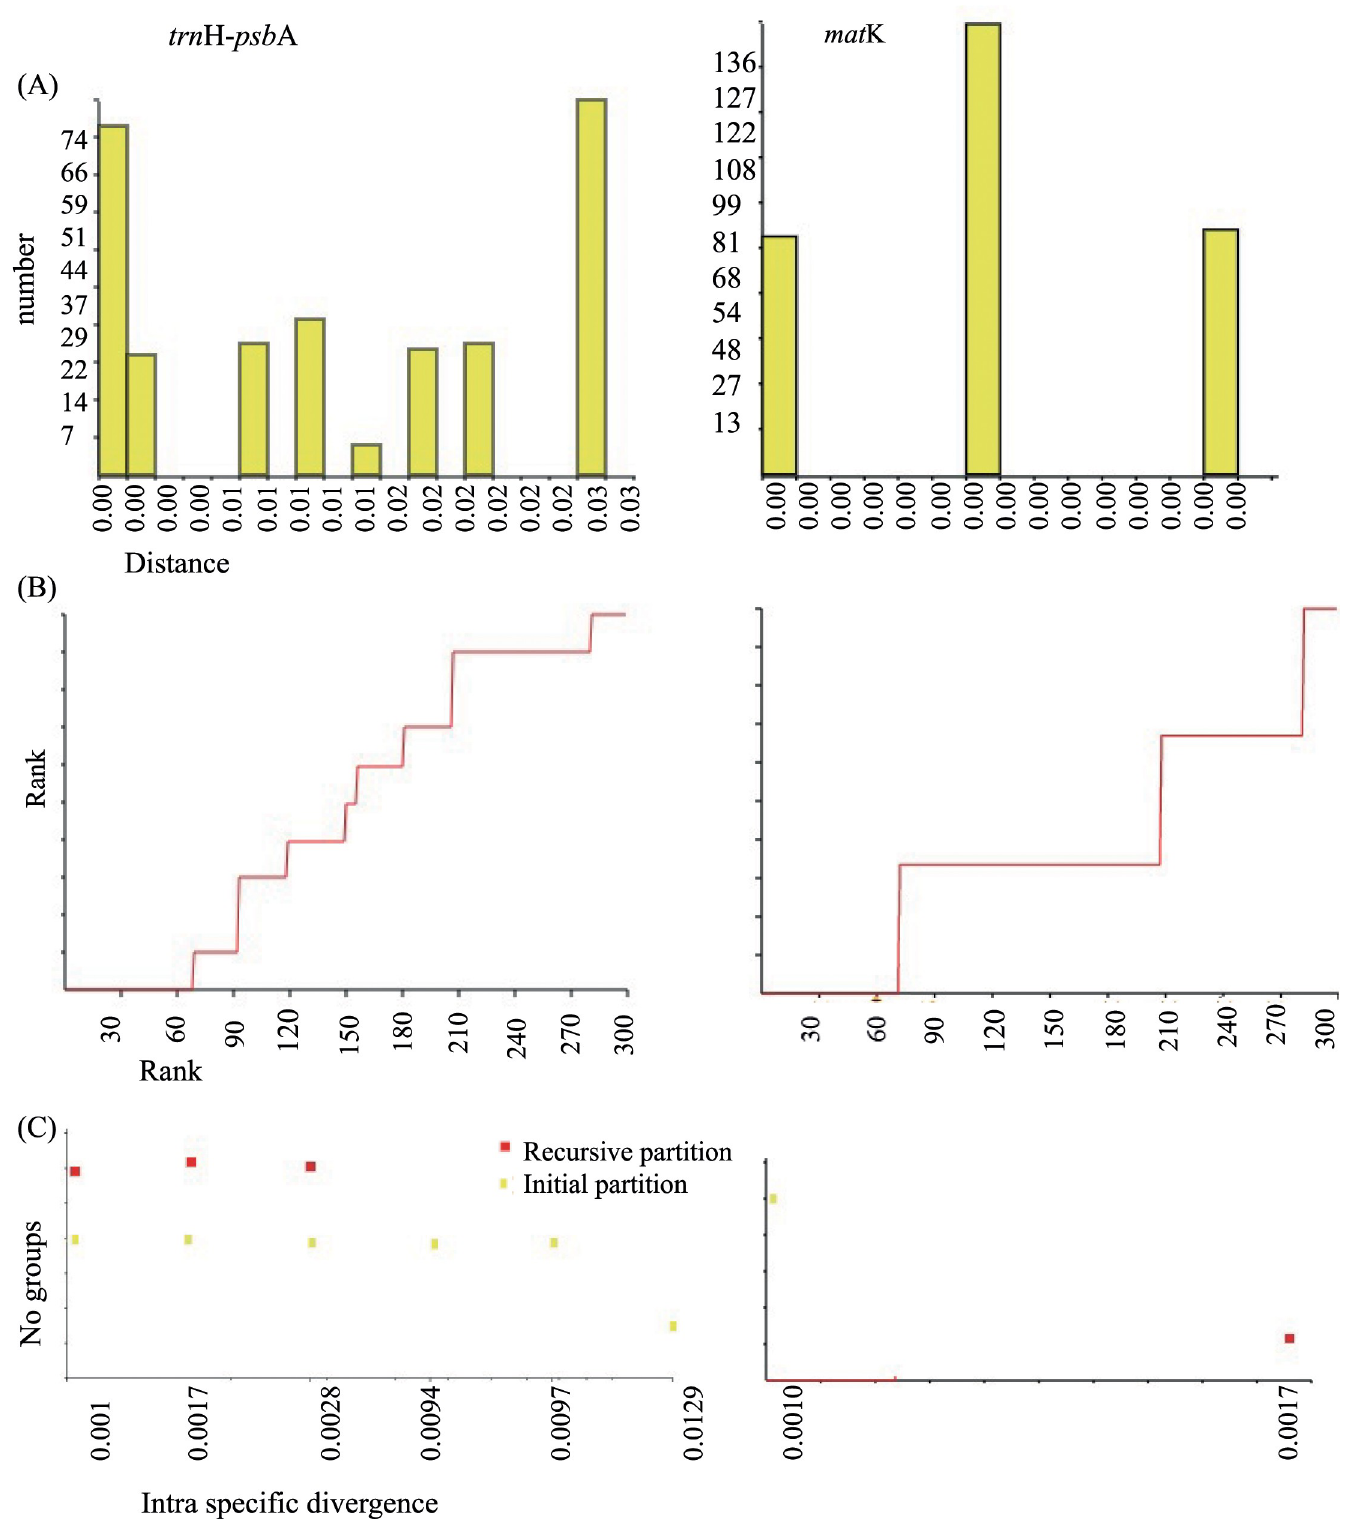
Fig 2. Schematic illustration of Automatic Barcode Gap Discovery (ABGD) with mat K and trn H- psb A regions for Cinnamomum species. (A) Distribution of pairwise differences. Low divergence represent intraspecific divergence, whereas higher divergence represents interspecific divergence (B) Ranked pairwise differences (C)